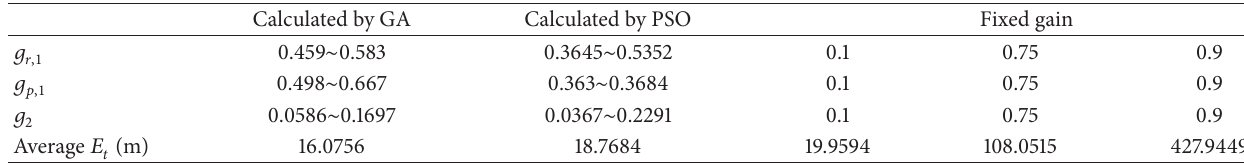
Table 7: Estimation errors for different gains.